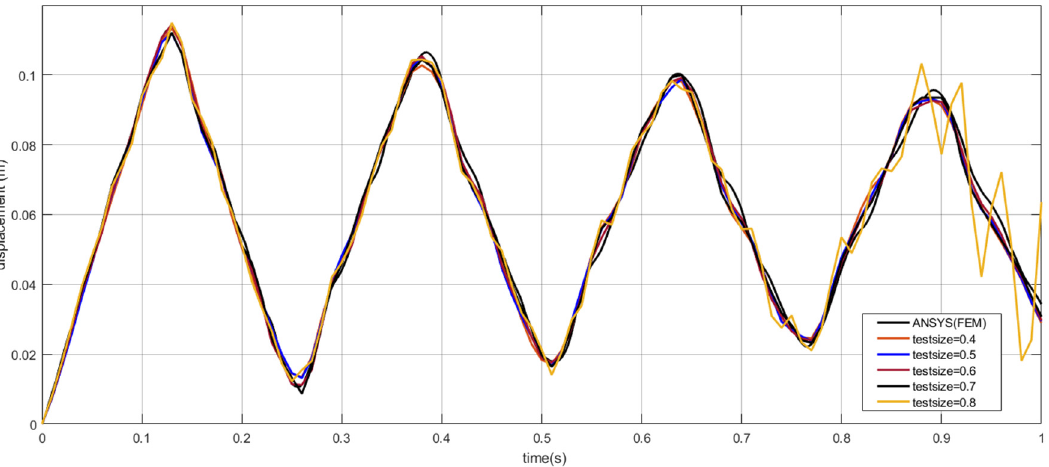
Figure 9. Influence of the test domain size in a cantilever beam under an end load (105 nodes with nodal distance d = 1.0 m, at point A).